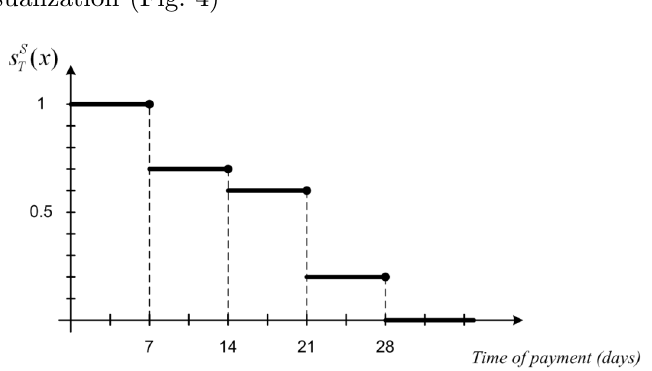
Figure 4. The Seller’s membership function for time of